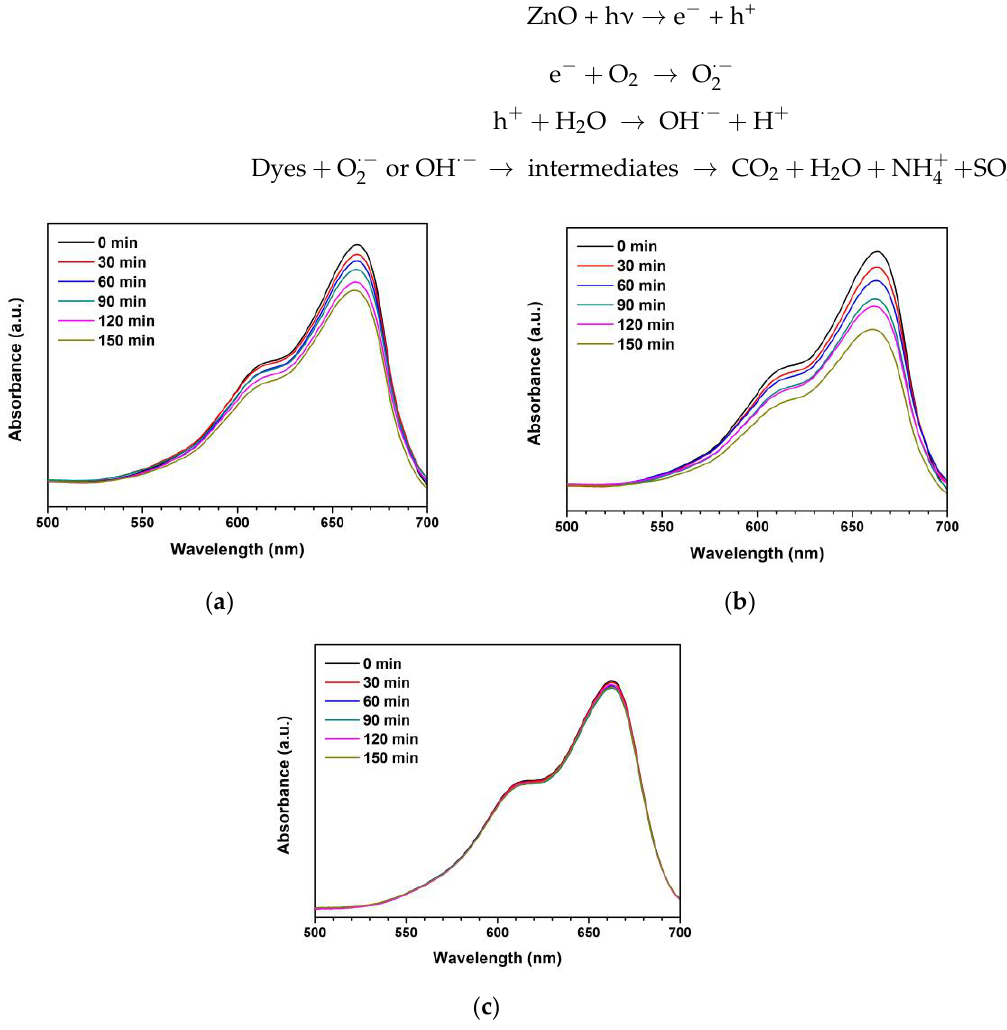
Figure 10. Absorbances of MB under photocatalytic degradation for different UV irradiation time using ( a ) ZnO photocatalyst, ( b ) Ti-ZnO photocatalyst, and ( c ) no photocatalyst.